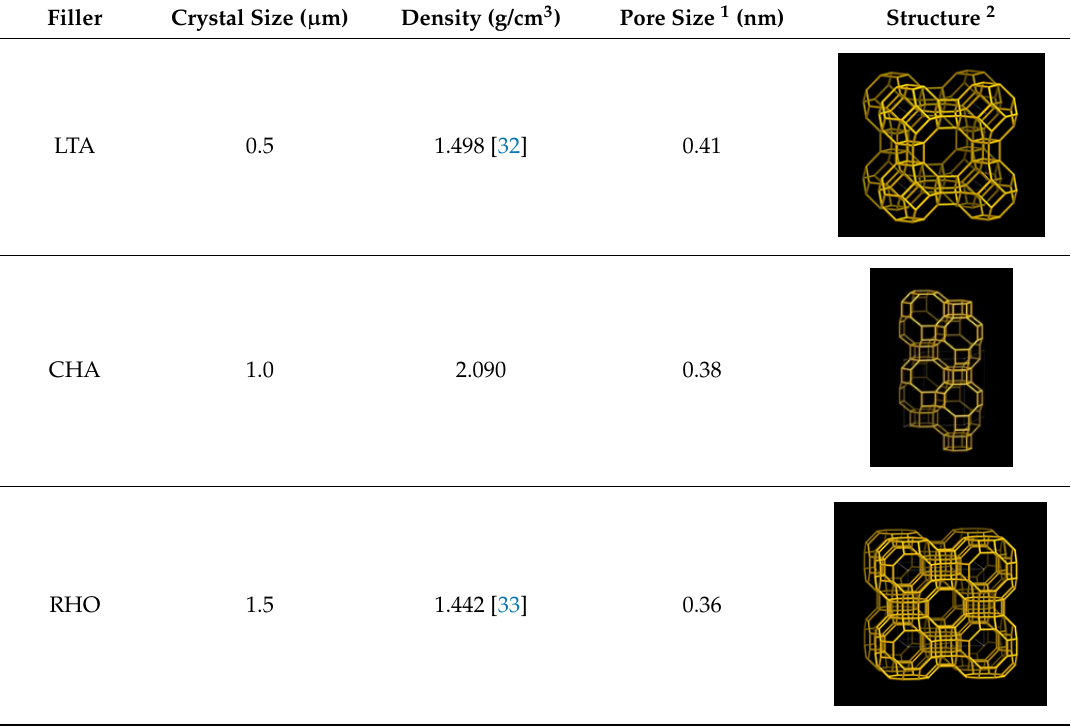
Table 1. Properties of the zeolite fillers with Si/Al = 5 used in this work.